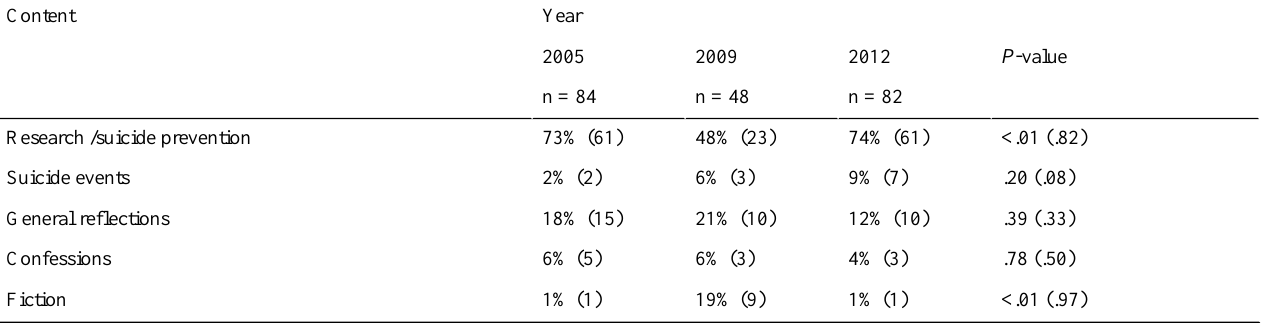
Table 4. The share of search hits on Google on the search term suicide distributed on the variable Content. In percent and (frequencies). In percent (and frequencies). P -values based on Fisher’s exact test for association (and Cochran-Armitage trend statistic in